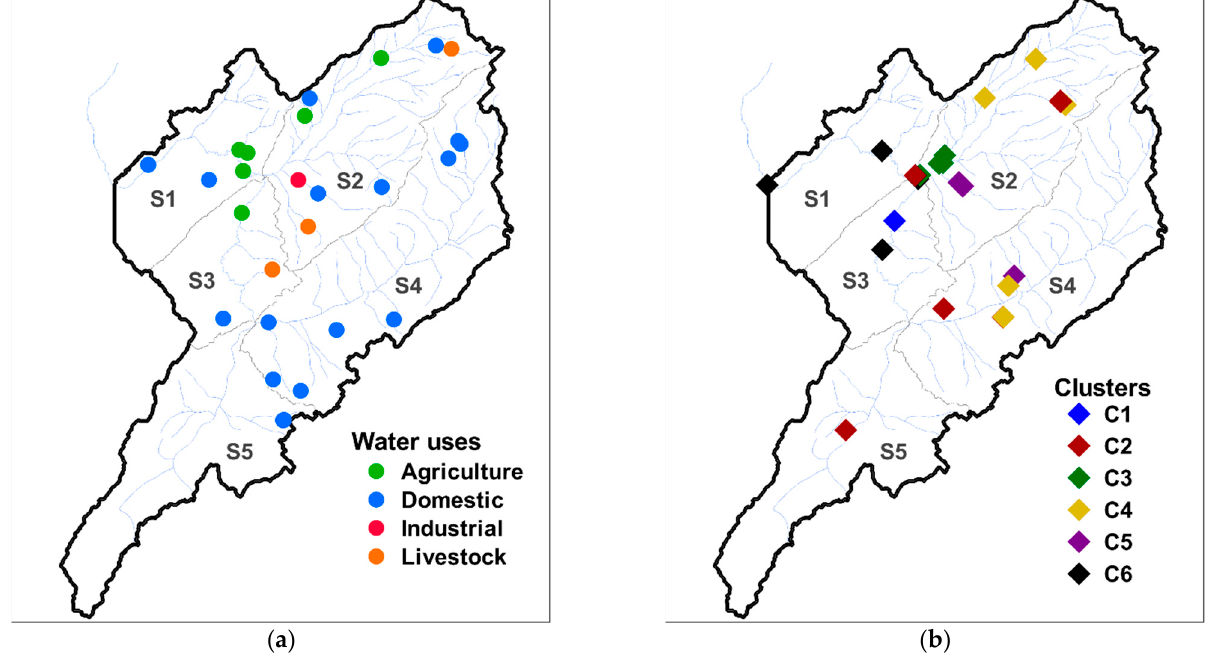
Figure 9. Location of: ( a ) water uses; ( b ) sites in each cluster.